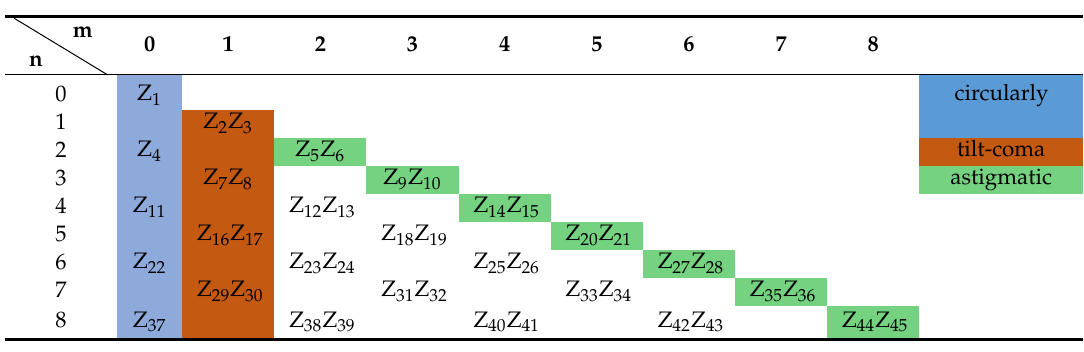
Table 1. Noll–Zernike Polynomial